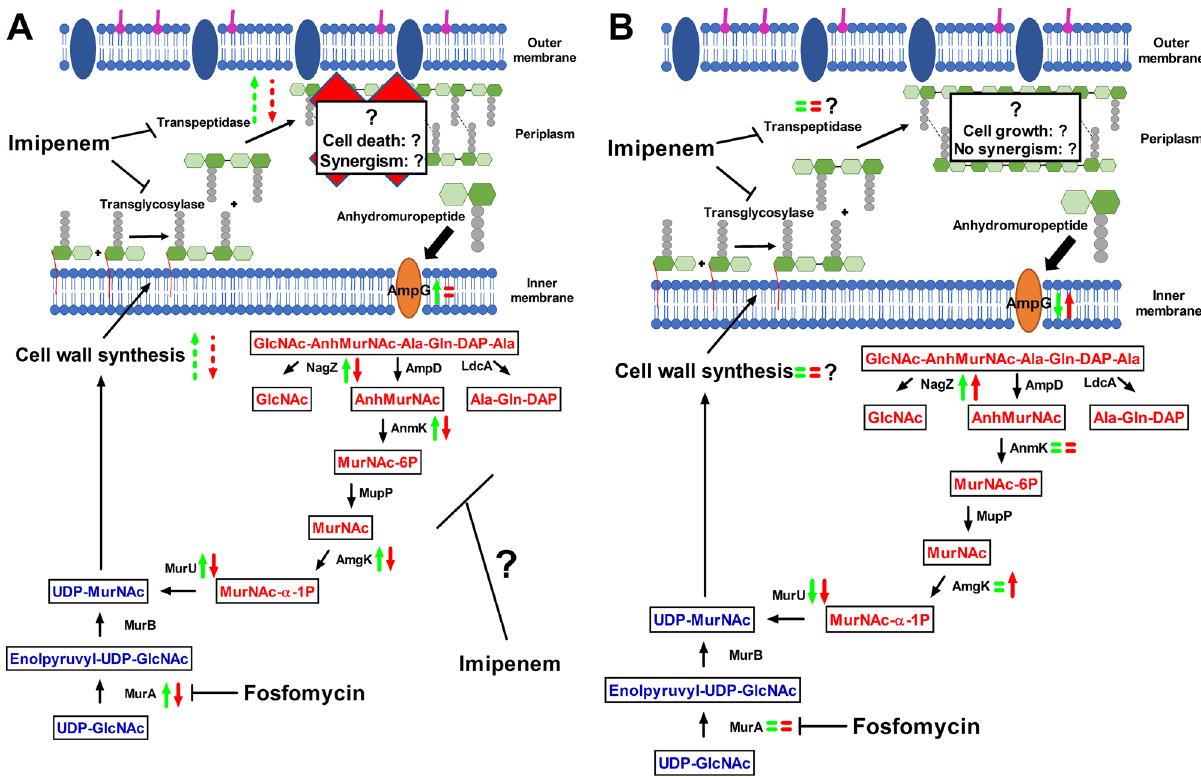
Figure 7. Summary of cell wall recycling gene expression and proposed mechanism of synergistic mechanism of imipenem and fosfomycin combination in A. baumannii A10 ( A ) and AB250 ( B ). The cell wall recycling expressions in Fig. 6 were summarized in this scheme. Green and red symbols are represented the gene expression in the presence of 0.5× fosfomycin MIC and in the combination of 0.5× fosfomycin MIC and 1× imipenem MIC, respectively. Upward arrows, downward arrows, and equal arrows are represented upregulation, downregulation, and not change of expression compared to without antibiotic, respectively. Question marks and dash arrows are represented the proposed results that did not determined. Red words in the boxes are represented metabolites in the cell wall recycling pathway. Blue words in the boxes are represented metabolites in the de novo cell wall